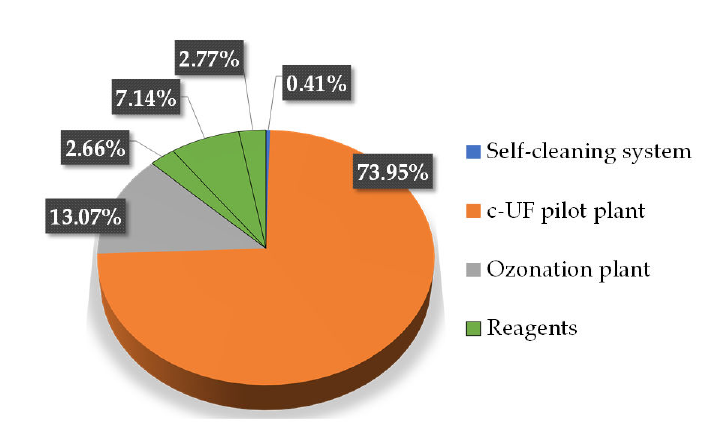
Figure 7. Partial costs ( € m − 3 ) of the proposed c-UF/ozonation treatment: c-UF (0.024), ozonation (0.0042) and reagents (0.00086), expressed as percent of the total cost of 0.0325 € m − 3